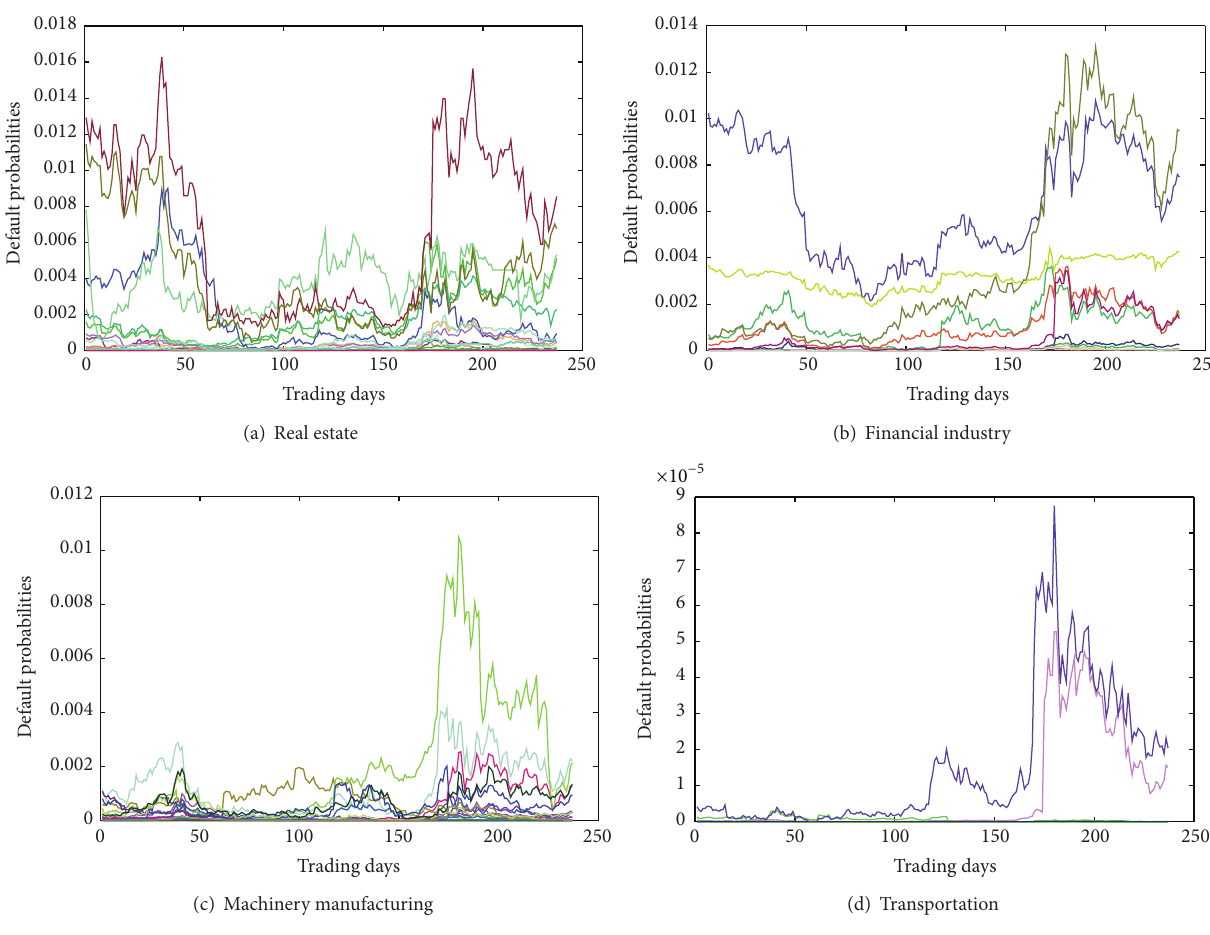
Figure 2: Dynamic default probabilities of four